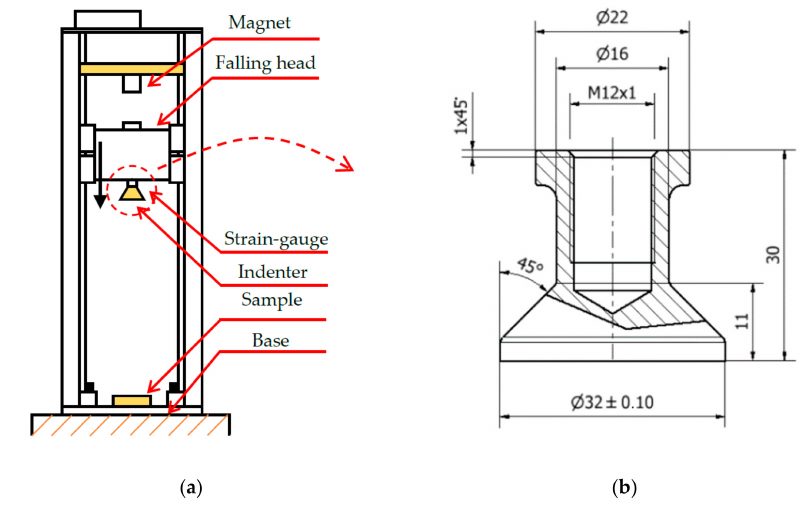
Figure 6. ( a ) Schema of the low-velocity impact tester; and ( b ) Geometry of the flat